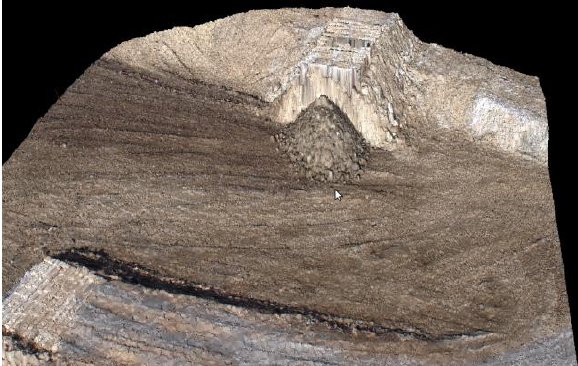
Fig. 5: TIN calculated from the matched 3D point cloud and textured using RGB values from the input images.